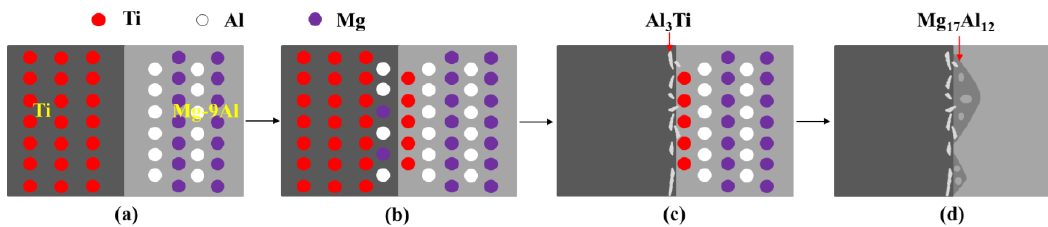
Figure 14. Schematic diagram of the metallurgical reaction mechanism of the solid/liquid interface. ( a , b ) diffusion of Ti atoms and Al atoms at the interface, ( c ) precipitation of Al 3 Ti phase in the Ti substrate and solid/liquid interface, ( d ) solidification of interfacial zone.